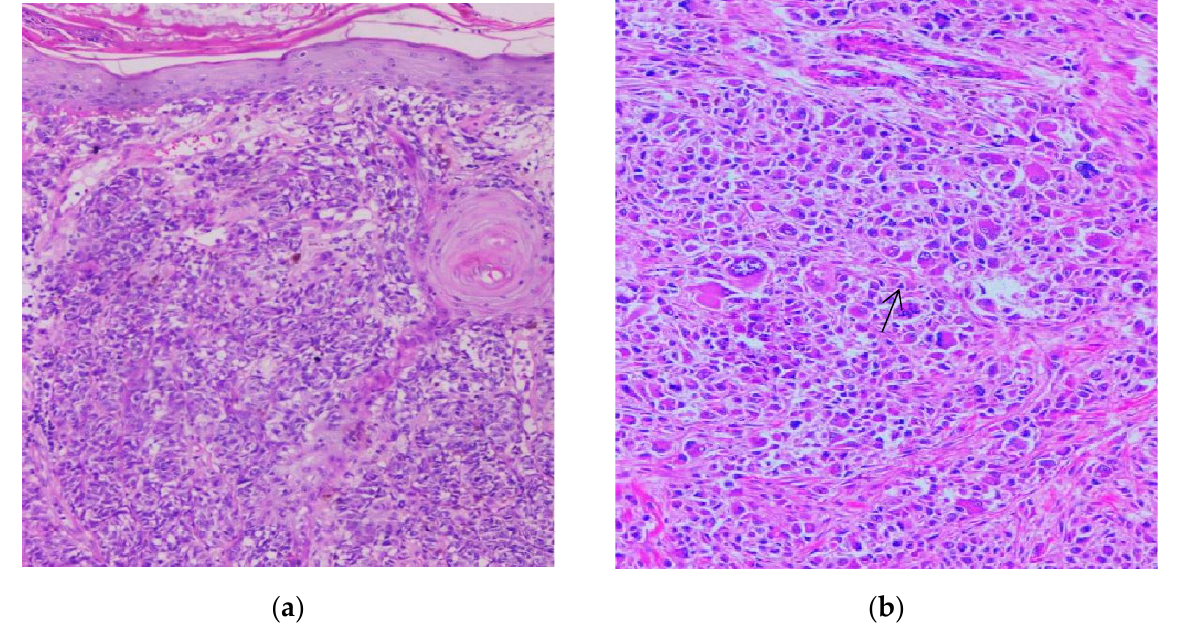
Figure 1. Nodular melanoma. ( a ) Nests and plaques of tumor cells can be observed at 5× magnifica- tion. ( b ) Cytological atypia (highly pleomorphic tumor cells with prominent nucleoli) can be iden- tified. Mitoses can be observed (arrow). 20× magnification. (Collection of Pathology Department SCJ Mure ș ).